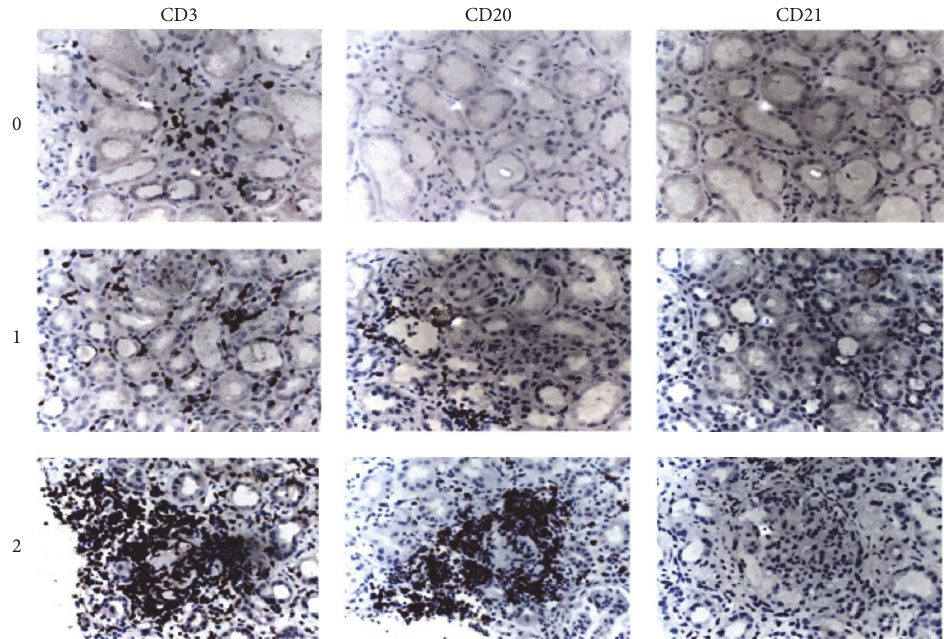
Figure 1: Ectopic lymphoid tissue classifications according to CD20, CD3, and CD21 immunohistochemical features in LN patients ( × 400). CD20, CD30, and CD21 were stained in serial sections. Class 0 had no CD20+ cell expression, with scattered CD3+ cells only, but without CD21+ cell expression; class 1 had scattered CD20+ cells and CD3+ cells infiltration, but without CD21+ cells infiltration; and class 2 had a nodular aggregation of CD20+ cells and CD3+ cells without CD21+ cell